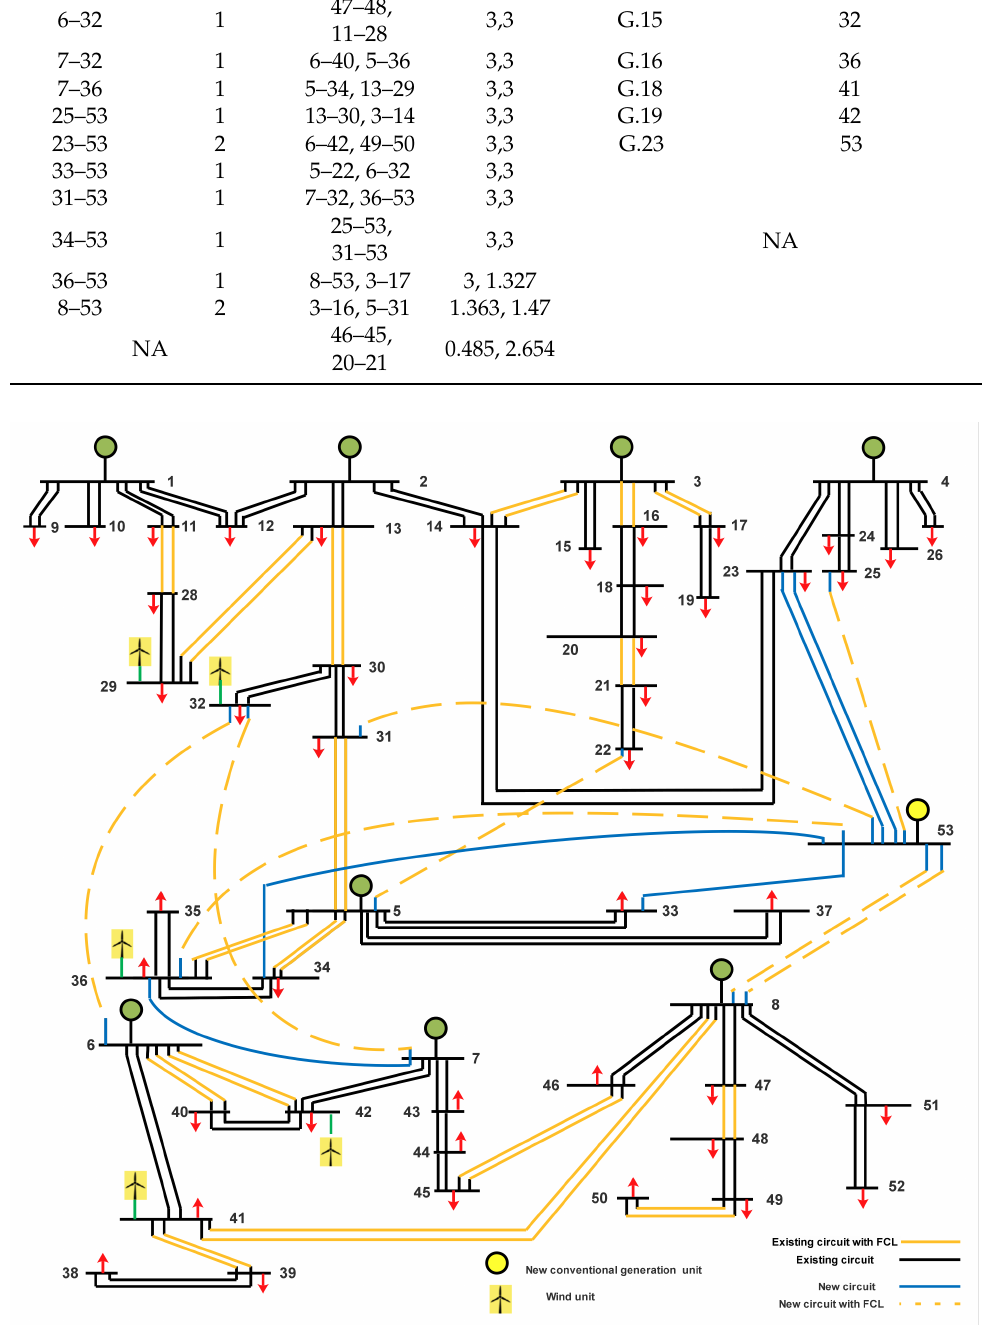
Figure 9. Final configuration of the